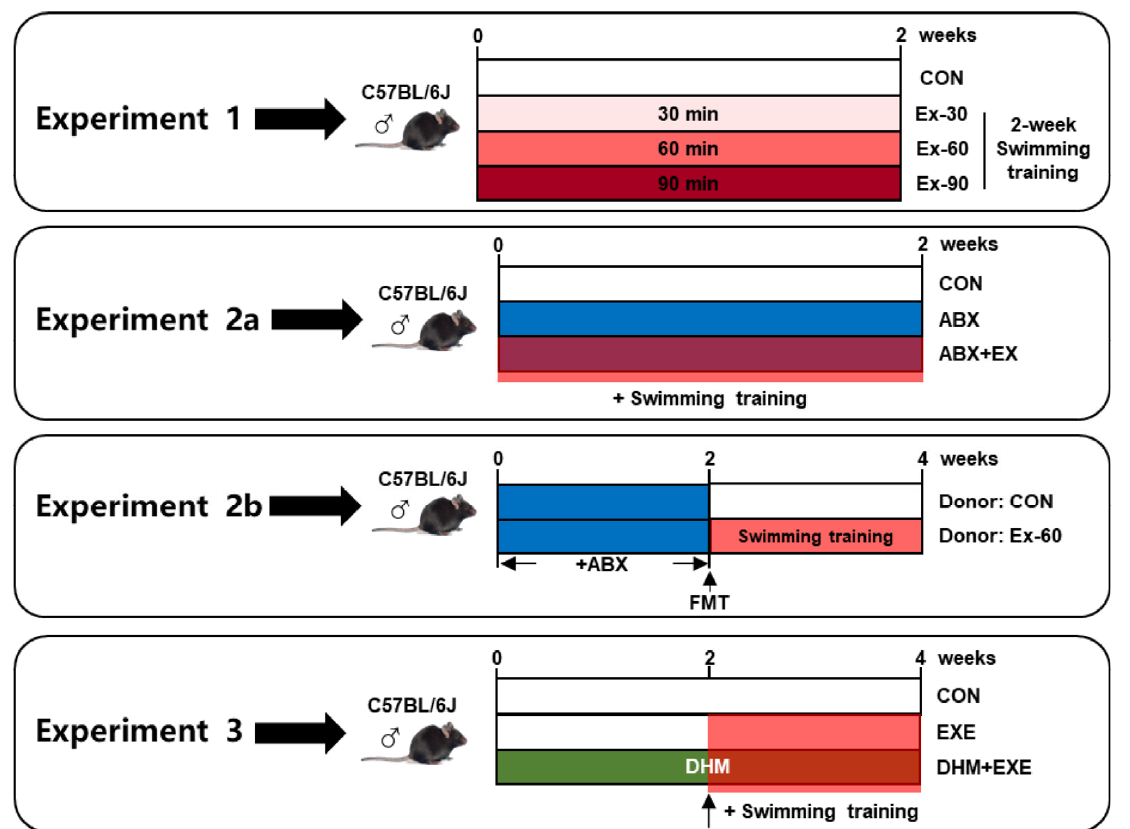
Figure 1. Schema showing the experiment design. Light red indicates 30 min swimming training, red indicates 60 min swimming training, dark red indicates 90 min swimming training, blue indicates ABX treatment, and green indicates DHM treatment.